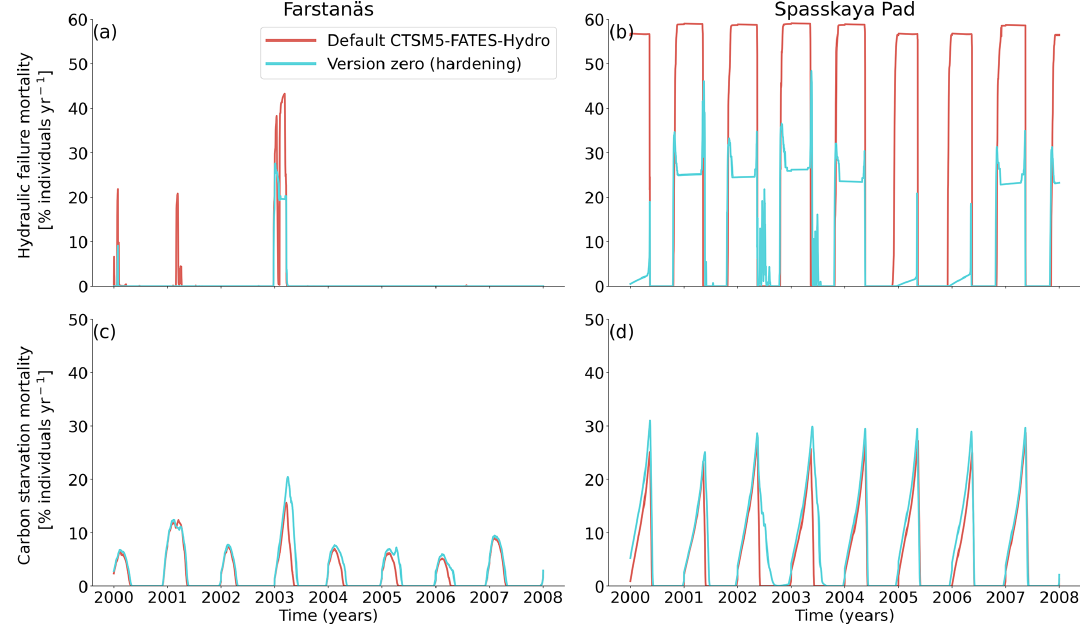
Figure 8. Mortality rates for evergreen needleleaf trees at the sites of (a,c) Farstanäs and (b,d) Spasskaya Pad during the period 2000–2008. (a,b) Hydraulic failure mortality and (c,d) carbon starvation mortality. The default simulation is shown in red, and the hardening simulation is shown in